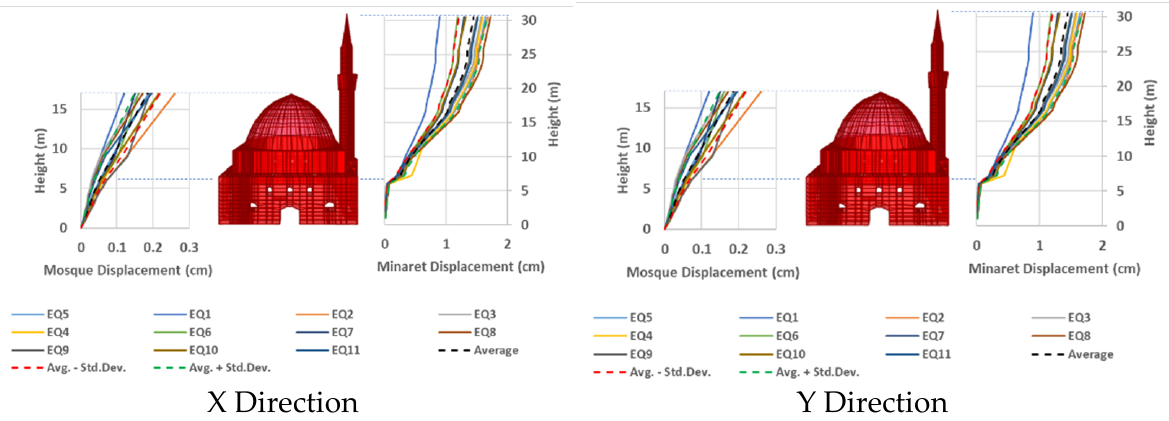
Figure 9. Mosque and minaret displacements for the base-isolated case.